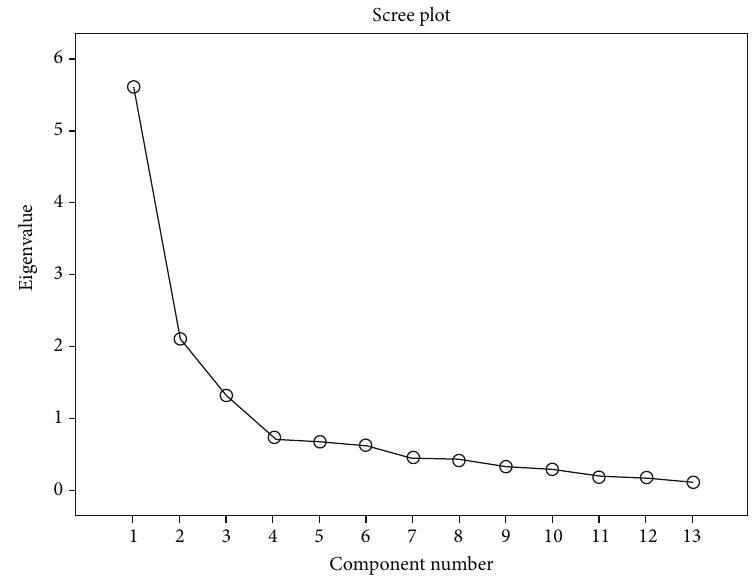
Figure 2: The Scree plot of items of the PSSS-Ina (components with high eigenvalues, > 1.0).